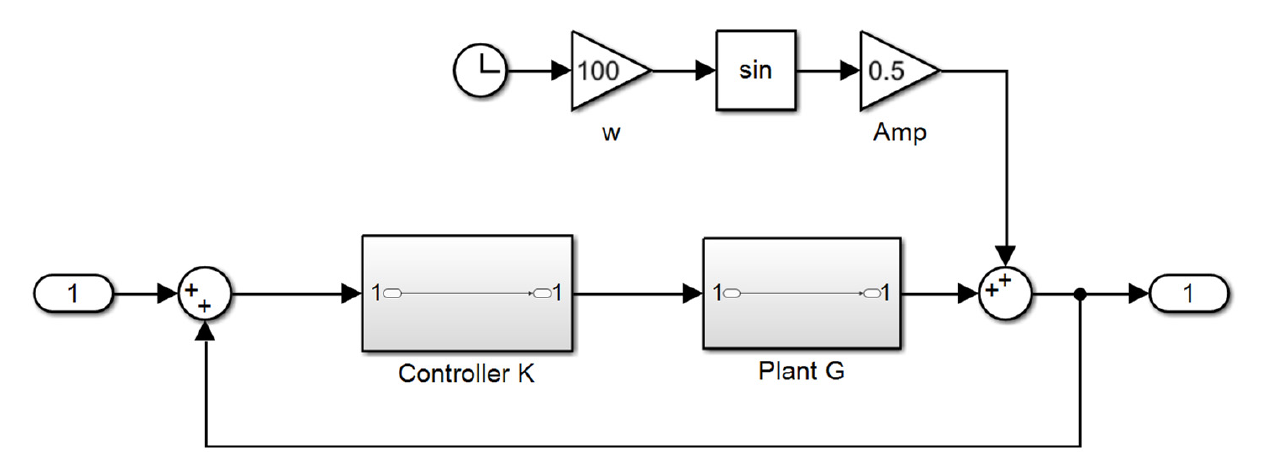
Figure 1. Basic Control Structure with Disturbance.